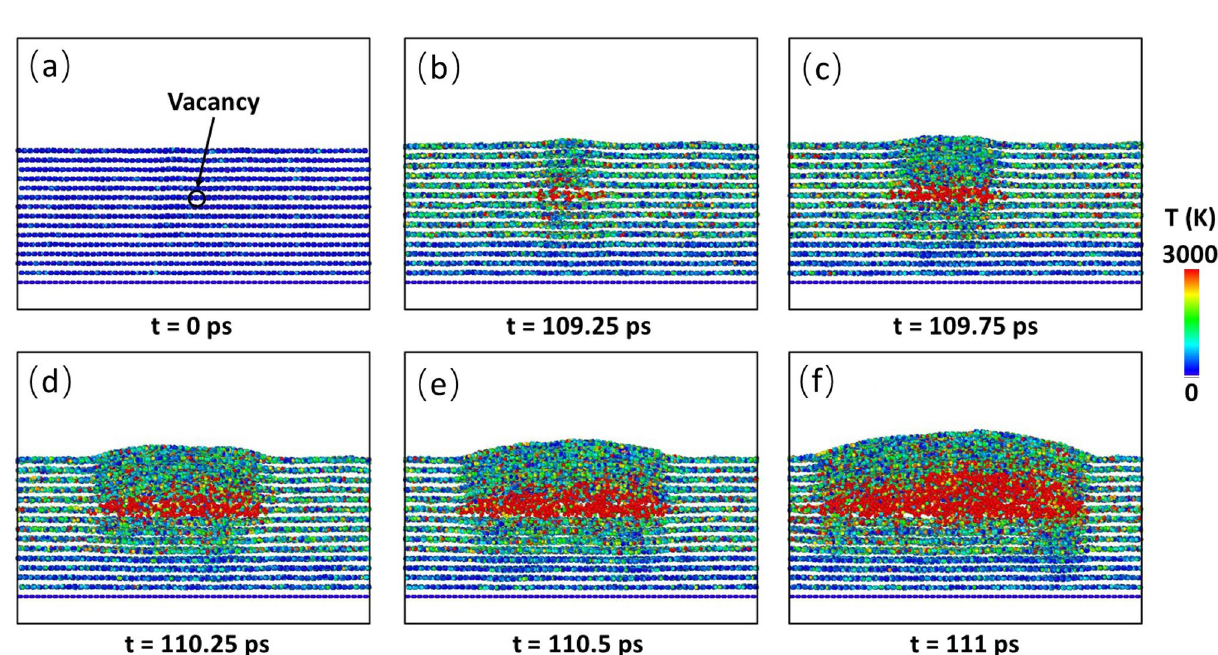
Figure 10. Snapshots of atomic temperature distributions in the 10-layer h-BN sample. The heating rate is 0.254 eV/atom/ps. One B vacancy is introduced into the middle of the 6th